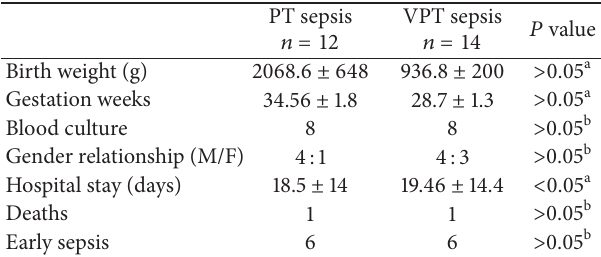
Table 1: Patients